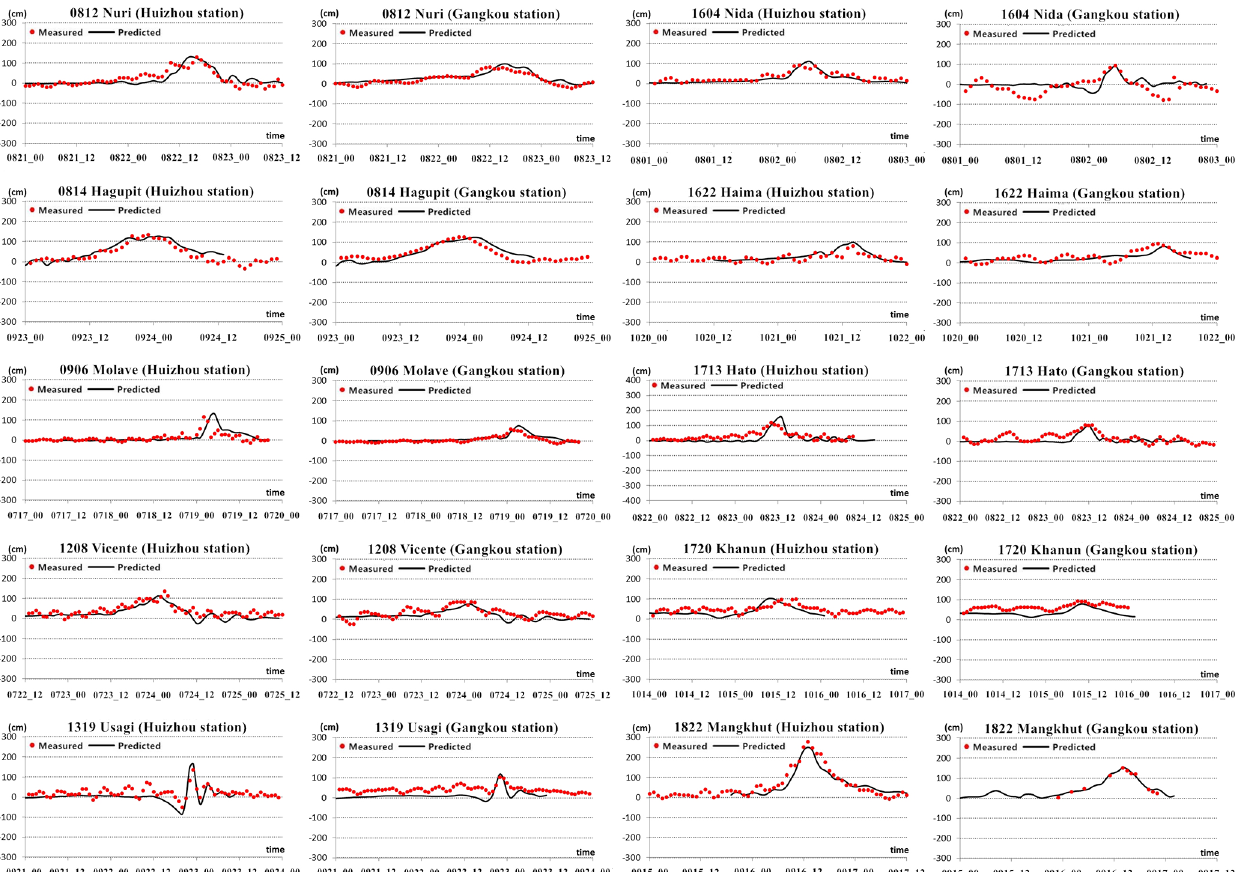
Figure 5. The predicted water levels (black line) and highest measured water levels (red dots) recorded by the Huizhou station and Gangkou station during the typhoon